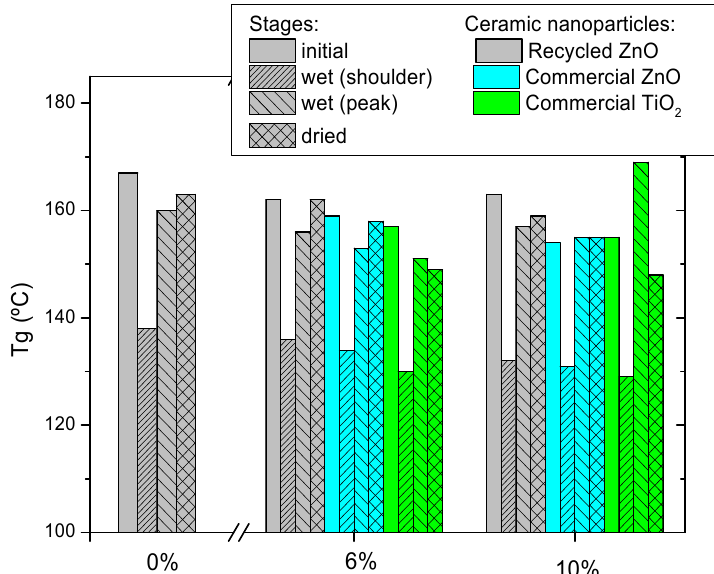
Figure 5. T g determined as the maximum of the tan δ peak for the studied composites reinforced with ceramic particles in different stages: as manufactured (initial), after hydrothermal aging (wet) and after the thermal drying treatment (dried).